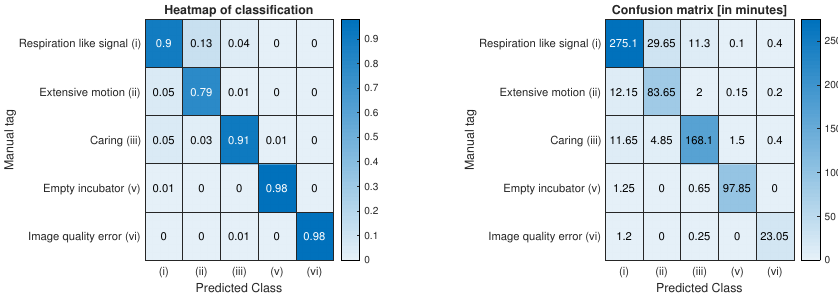
Figure 7. Confusion matrix of the main categories in a representative 12 h set.